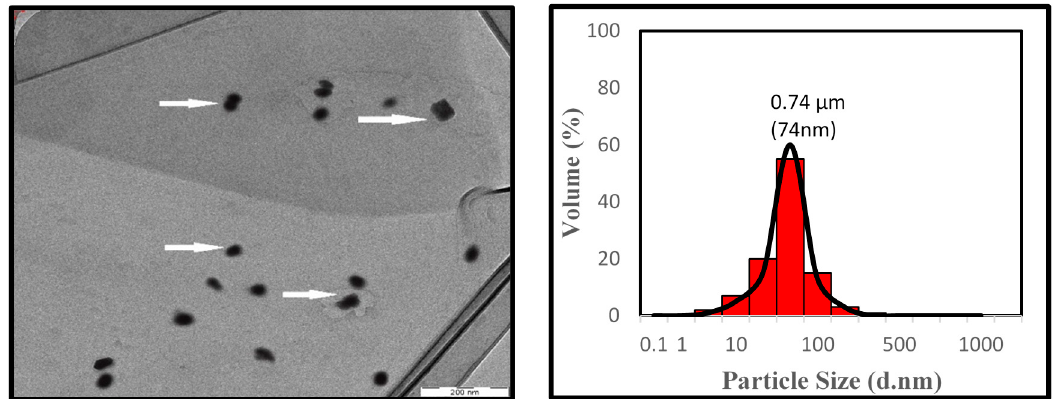
Figure 2. TEM micrograph and particle size distribution graph of oil palm ash nanoparticles.